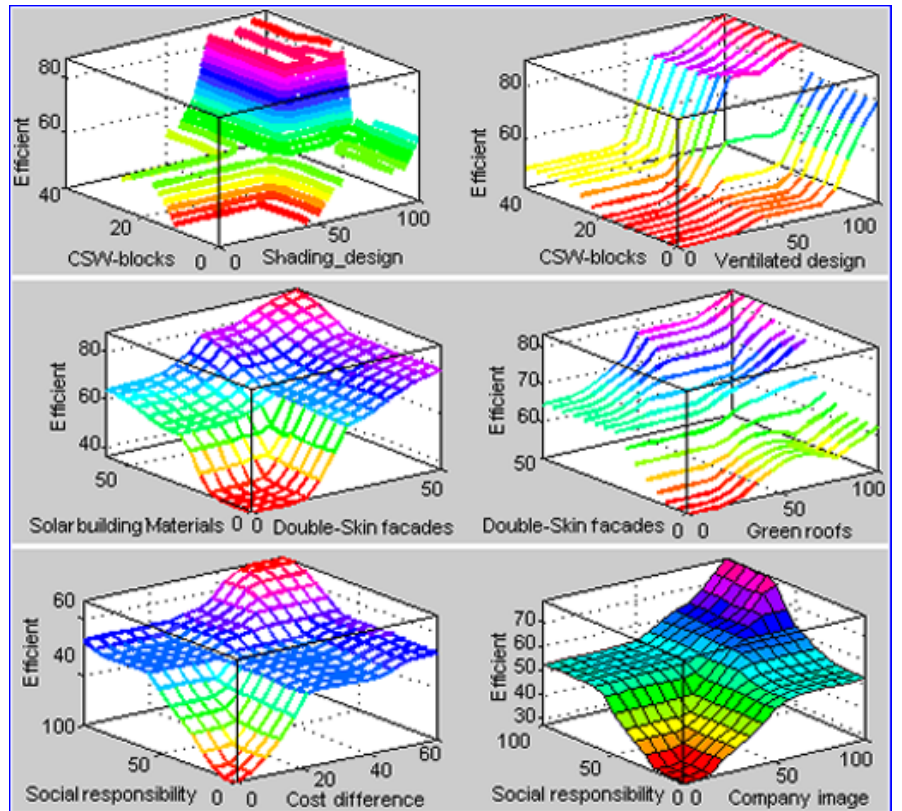
Figure 3. 3D mapping relationship diagram for input and output scenarios.